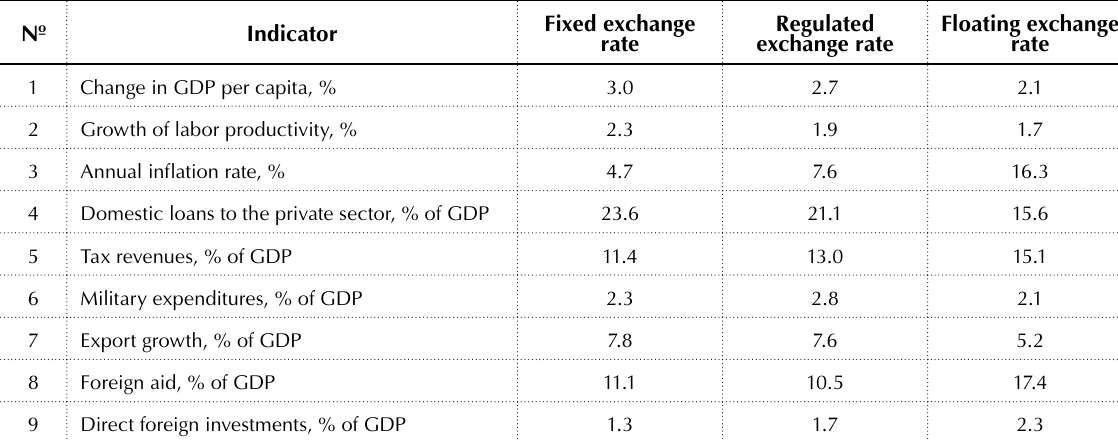
Table 1. Macroeconomic indicators of conflict economies according to exchange rate systems